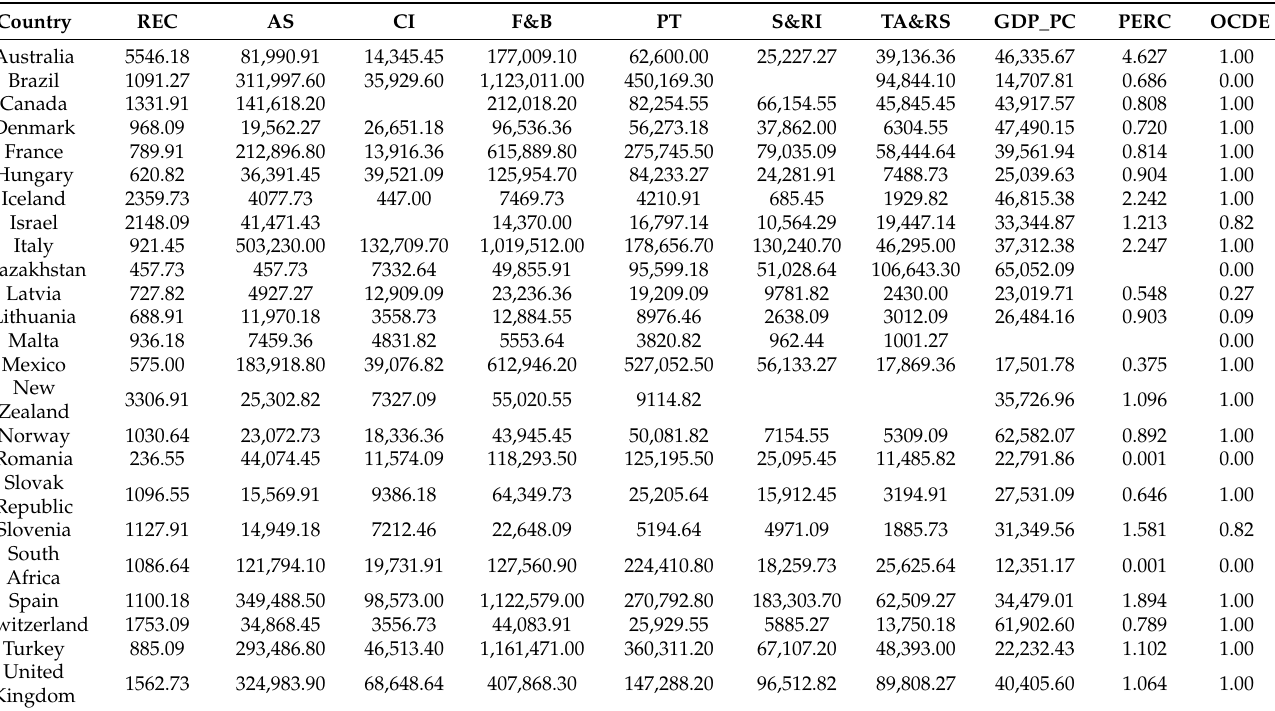
Table A2. Mean values (2008–2018) of the set of variables for each country.